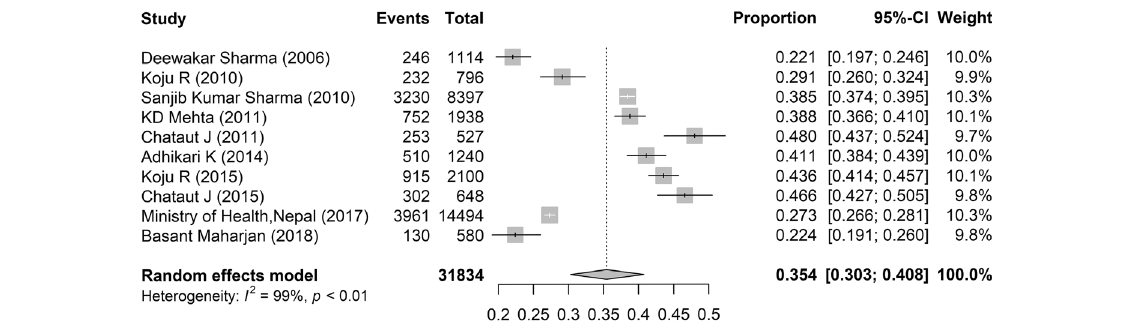
Fig. 3 Prevalence of prehypertension in Nepal